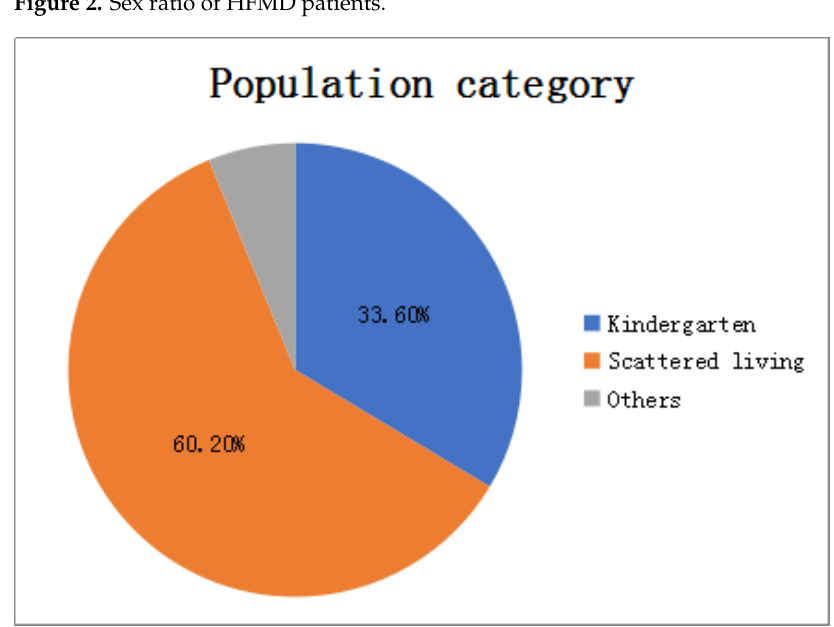
Figure 2. Sex ratio of HFMD patients.